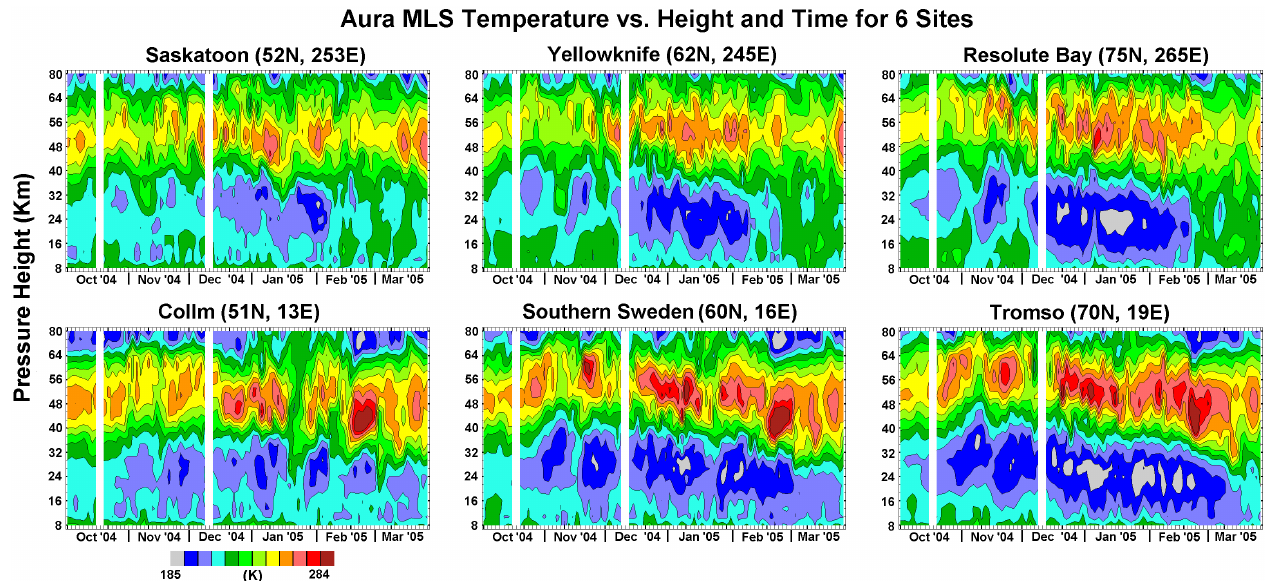
Fig. 2. Temperatures (Aura MLS) for three locations during the winter of 2004/2005 in each of the Canada and Scandinavia-Europe sectors: the locations-sizes are 25 ◦ in longitude and 1 ◦ in